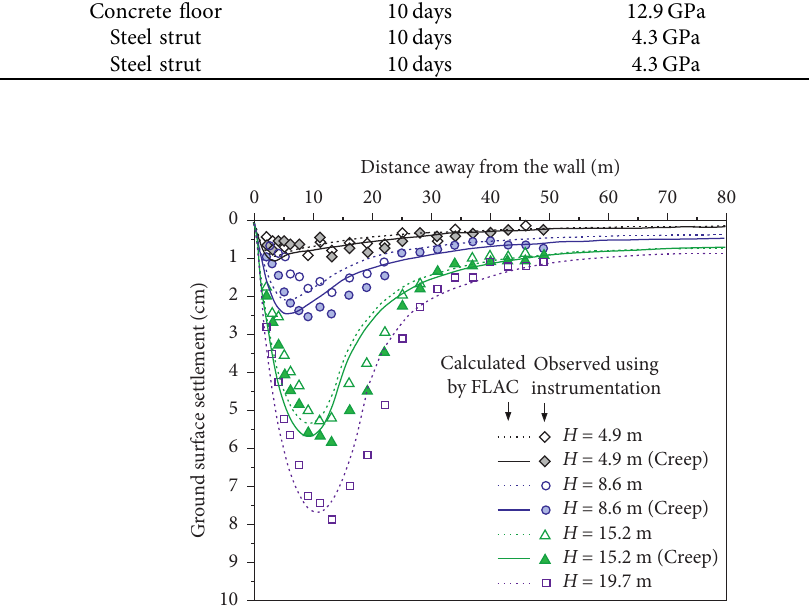
Figure 7: Calculated and observed time-dependent ground surface settlements in the TNEC project, modified from [33].